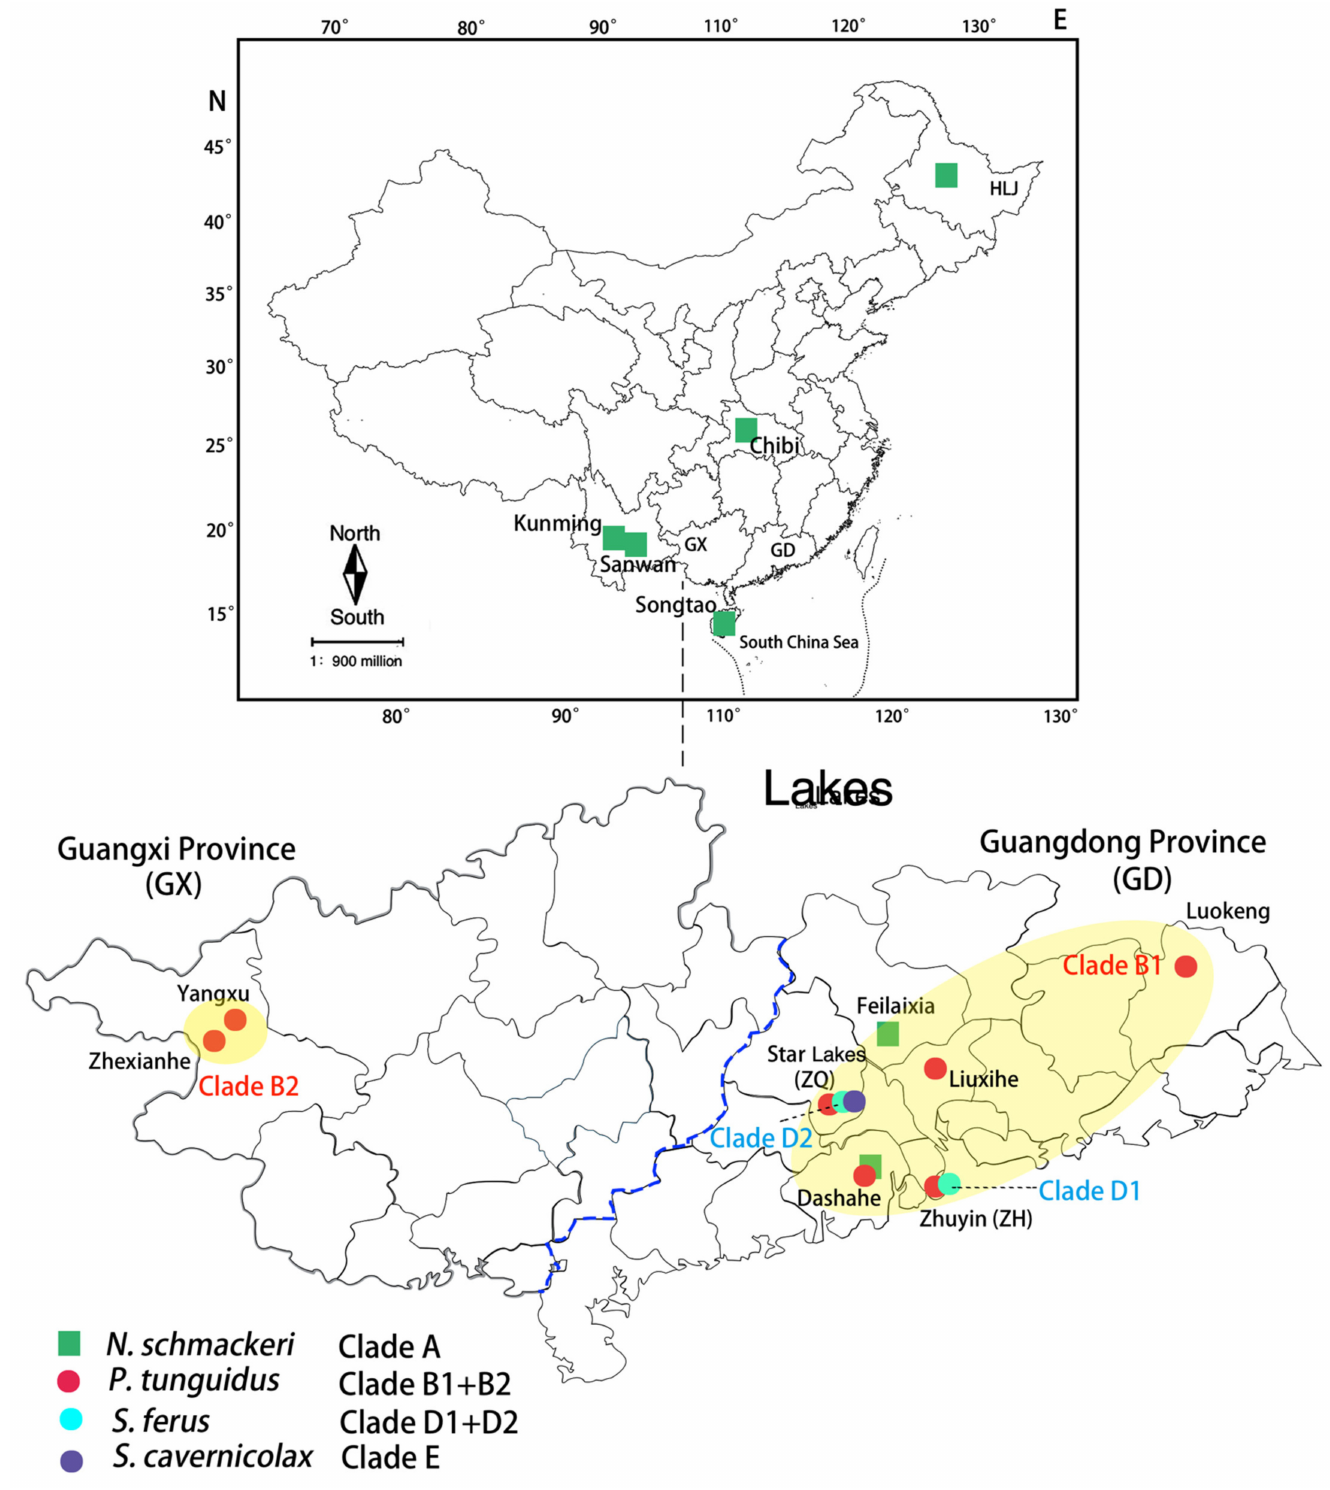
Figure 1. Thirteen sampling sites in China (Clade B1: P. tunguidus populations in Guangdong province (GD); Clade B2: P. tunguidus populations in Guangxi province (GX); Clade D1: S. ferus population in Zhuyin Reservoir, Zhuhai City, Guangdong province (ZH); Clade D2: S. ferus population in Star Lakes, Zhaoqing City, Guangdong province